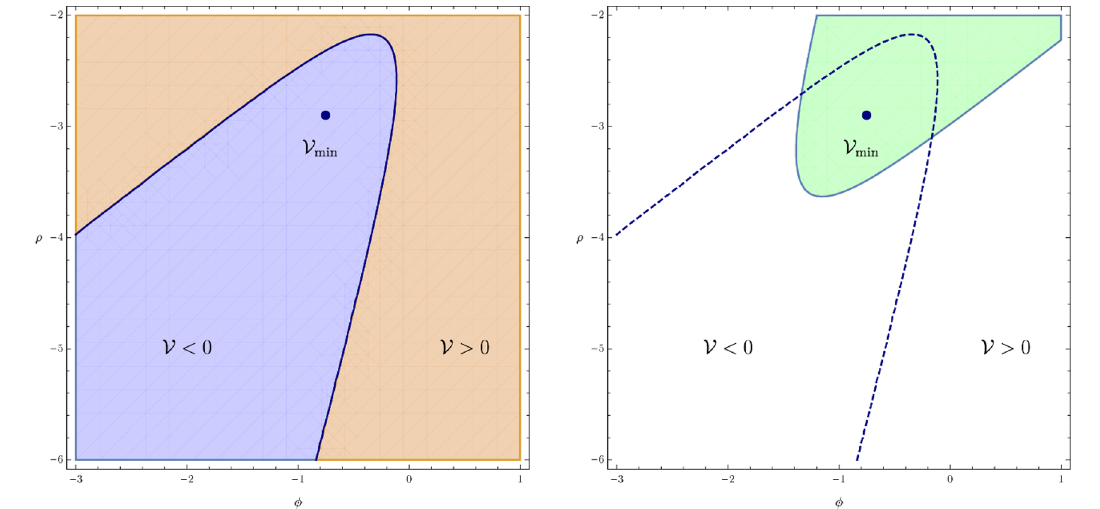
Figure 2 . Plots of the regions where the potential in eq. (5.14) is positive and negative de(cid:12)nite (left) and the region of stability, where the hessian is positive de(cid:12)nite (right), for the SO (16) (cid:2) SO (16) heterotic model. We have chosen n = 10 and V is expressed in units of T